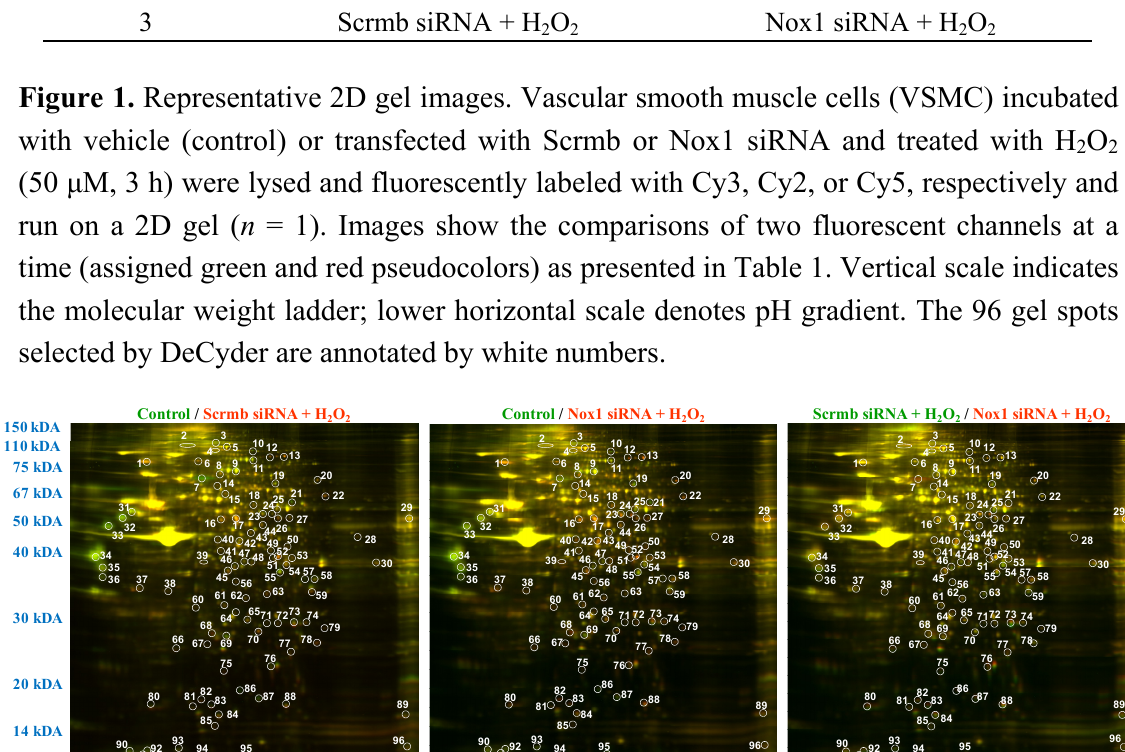
Table 1. Comparisons among treatment groups conducted by the DeCyder software. Comparison